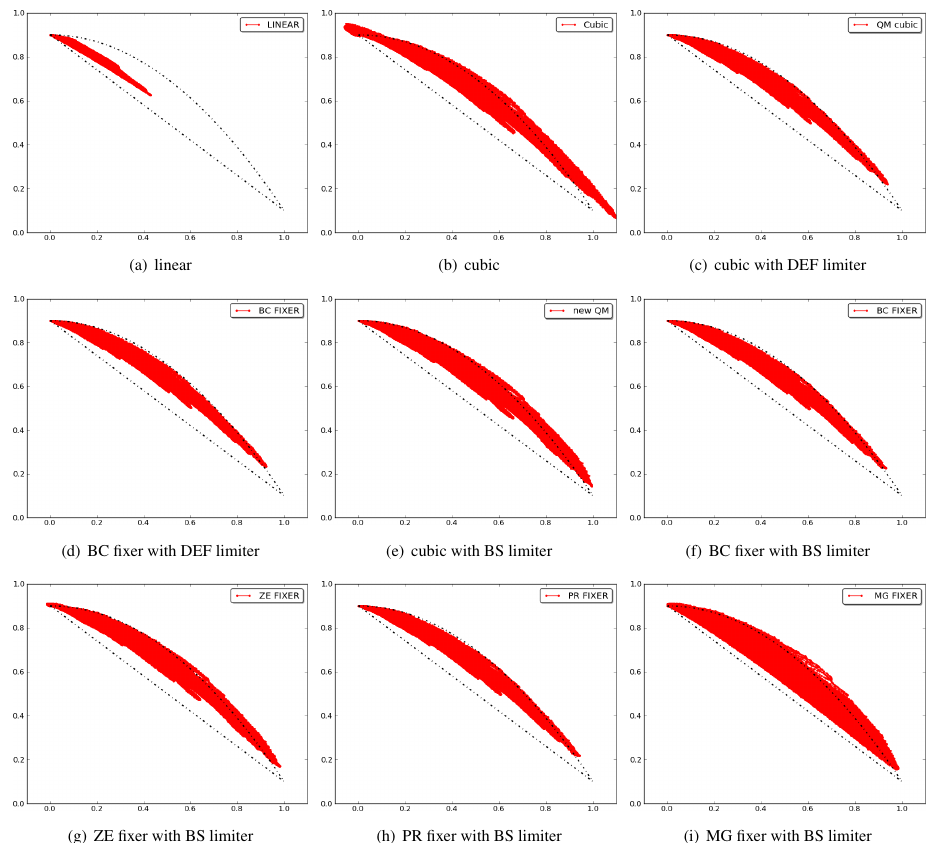
Fig. 7. q 1 - q 2 ( xy -axis) scatter plots for correlated tracers at t = 6 days. Scatter points ( q 1 , q 2 ) at t = 0 follow the upper (parabolic) black dashed-dotted curve.